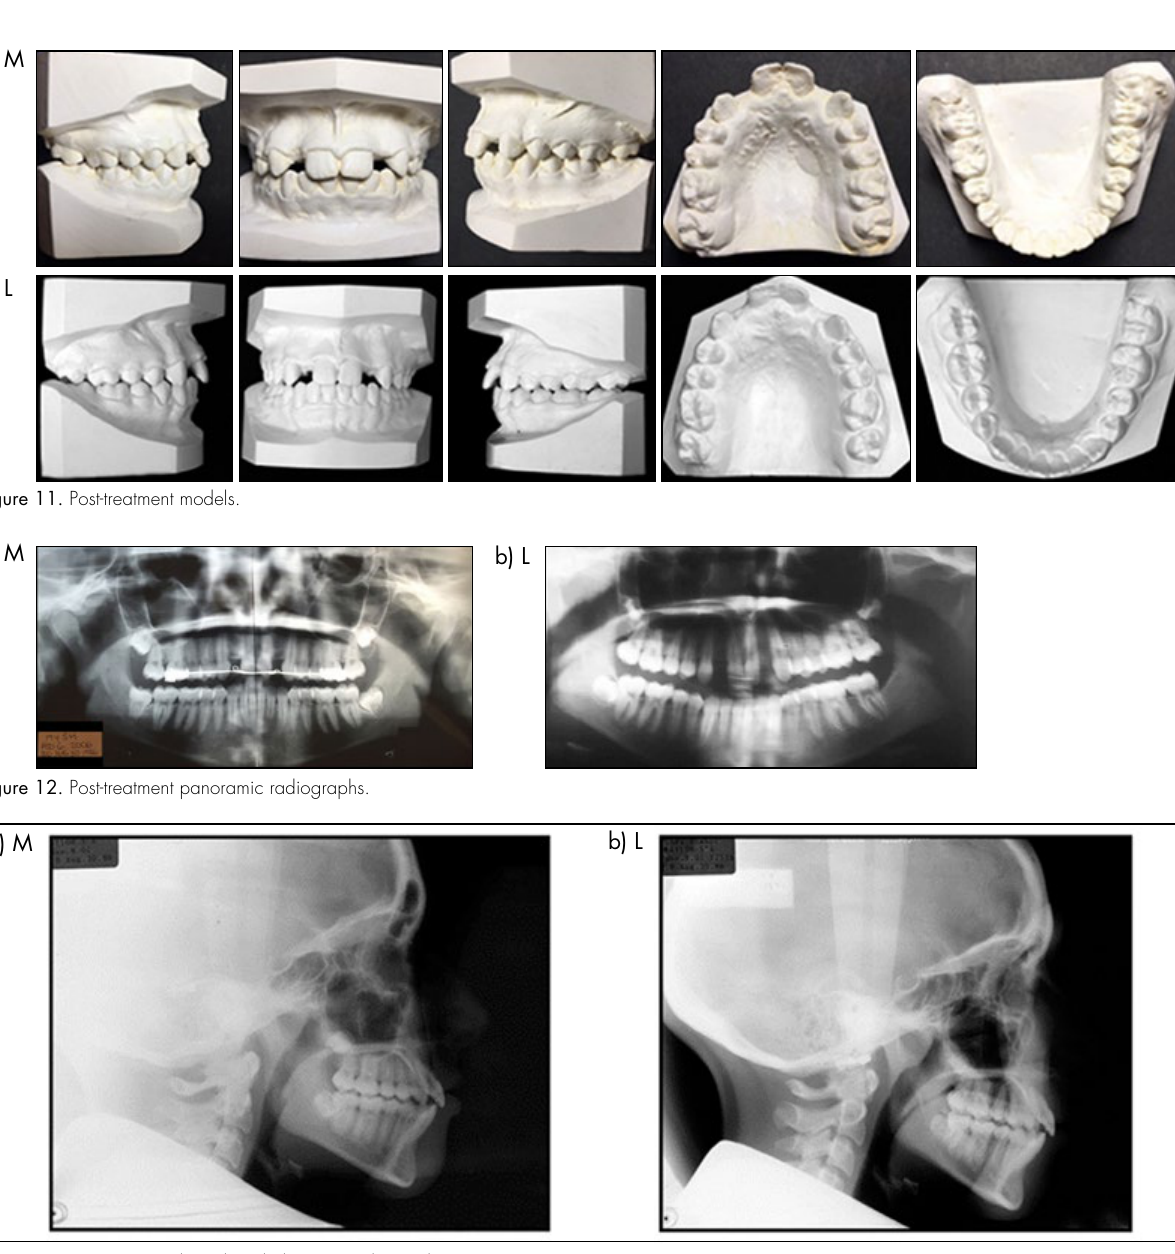
Figure 13. Post-treatment lateral cephalometric